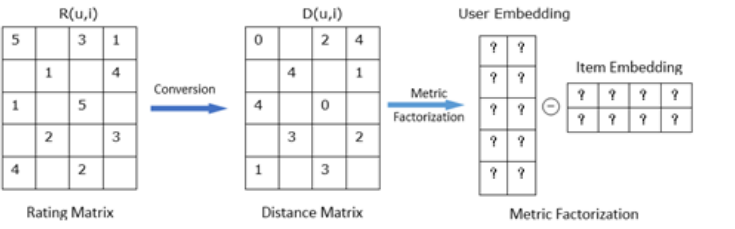
Figure 3. Rating matrix is turned into a distance matrix, and then, metric factorization is